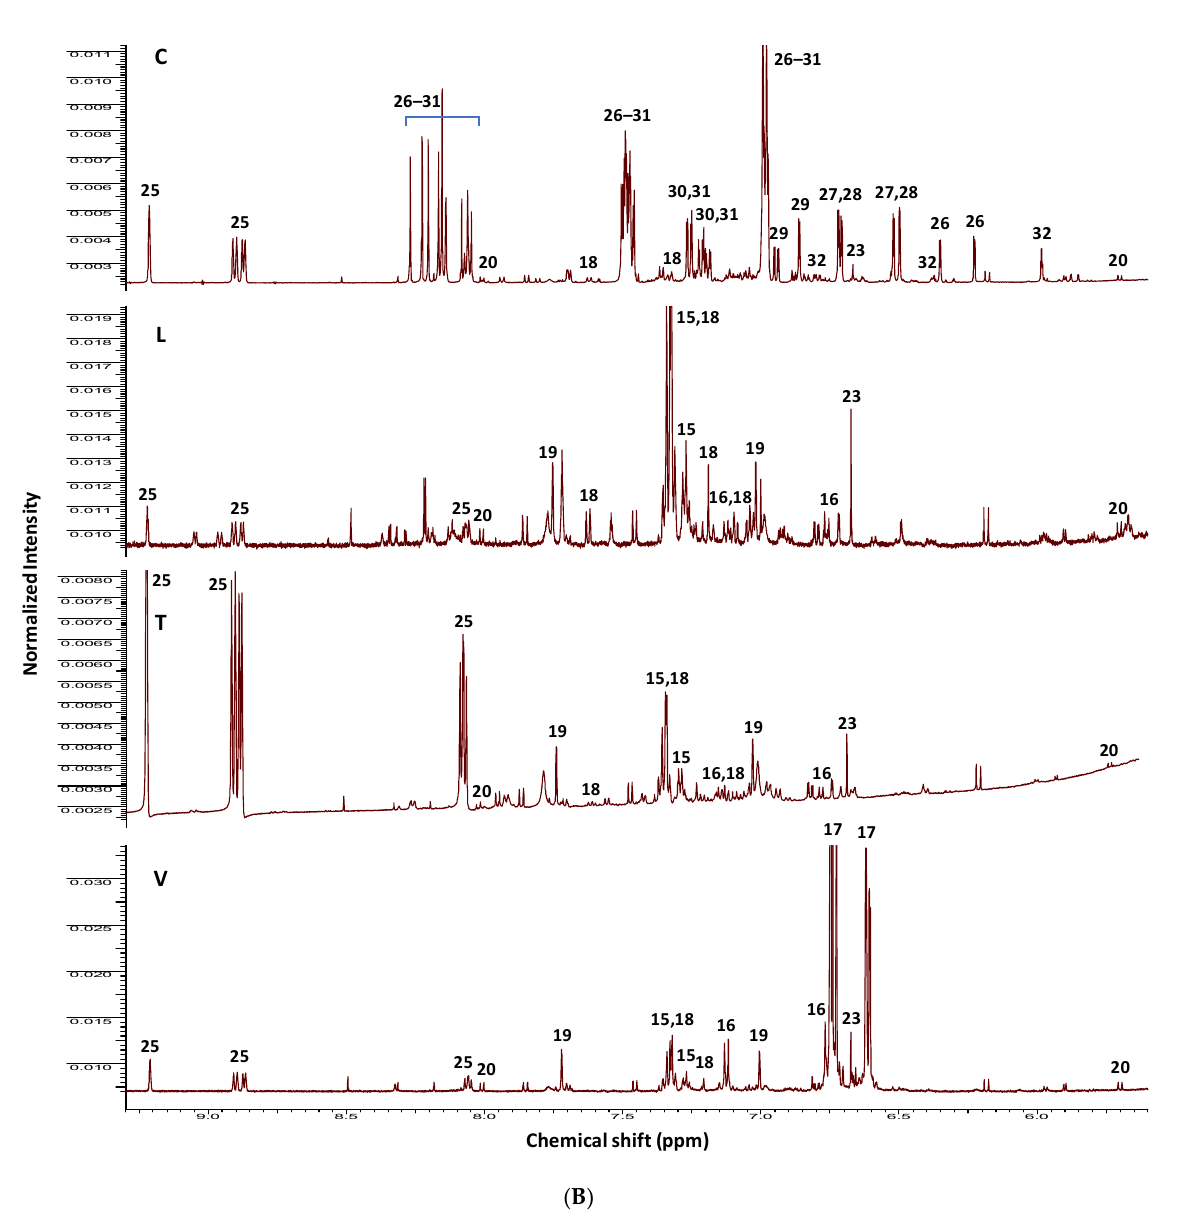
Figure 1. ( A ) 1 H-NMR spectrum of legume sprout methanol extracts (C, Cicer ; L, Lens ; T, Trigonella ; V, Vicia ) showing characteristic signals for primary and secondary metabolites in the range δ 0.5–5.5 ppm, and ( B ) in the range δ 5.6–9.3 ppm. The identities of NMR peaks are listed in Table 1.